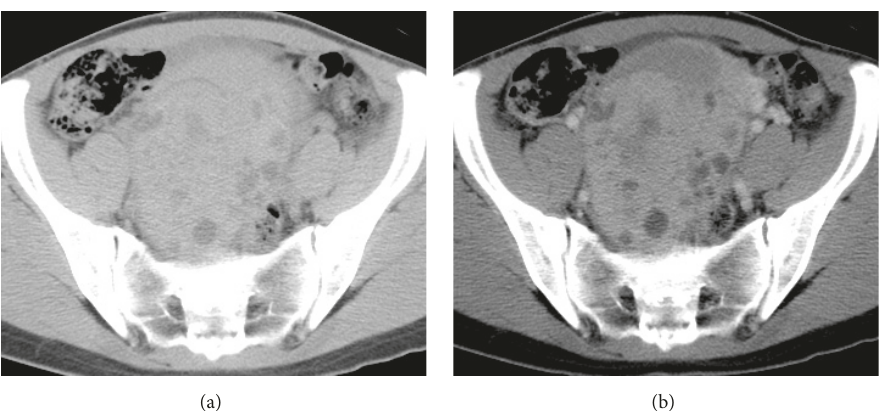
Figure 1: (a) Plain axial computed tomography (CT) depicting a mass of approximately 12 × 9 cm with heterogeneous density. (b) Contrast- enhanced axial CT showing the cystic area of the enhanced solid mass.